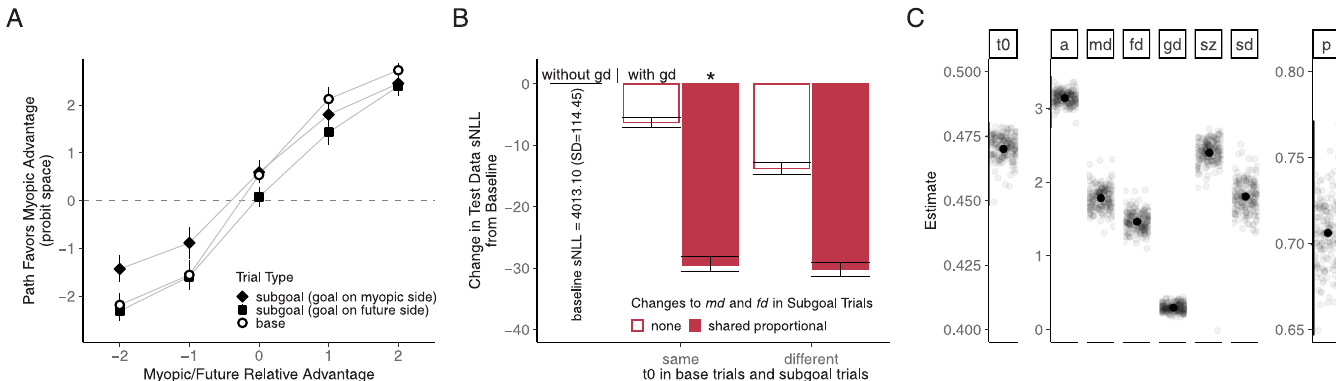
PLOS Computational Biology | https://doi.org/10.1371/journal.pcbi.1009553 June 16,